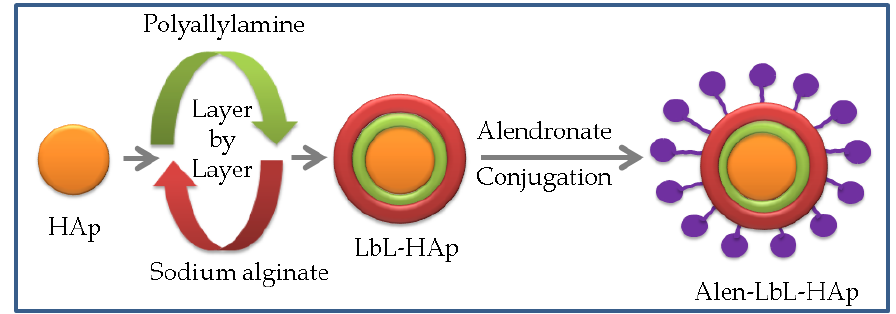
Figure 13. Scheme sowing the preparation of nHAp particles coated with a multilayer able to conjugate Alen. Adapted from [153], The Polymer Society of Korea and Springer Sciene + Business Media Dordrecht, 2016.